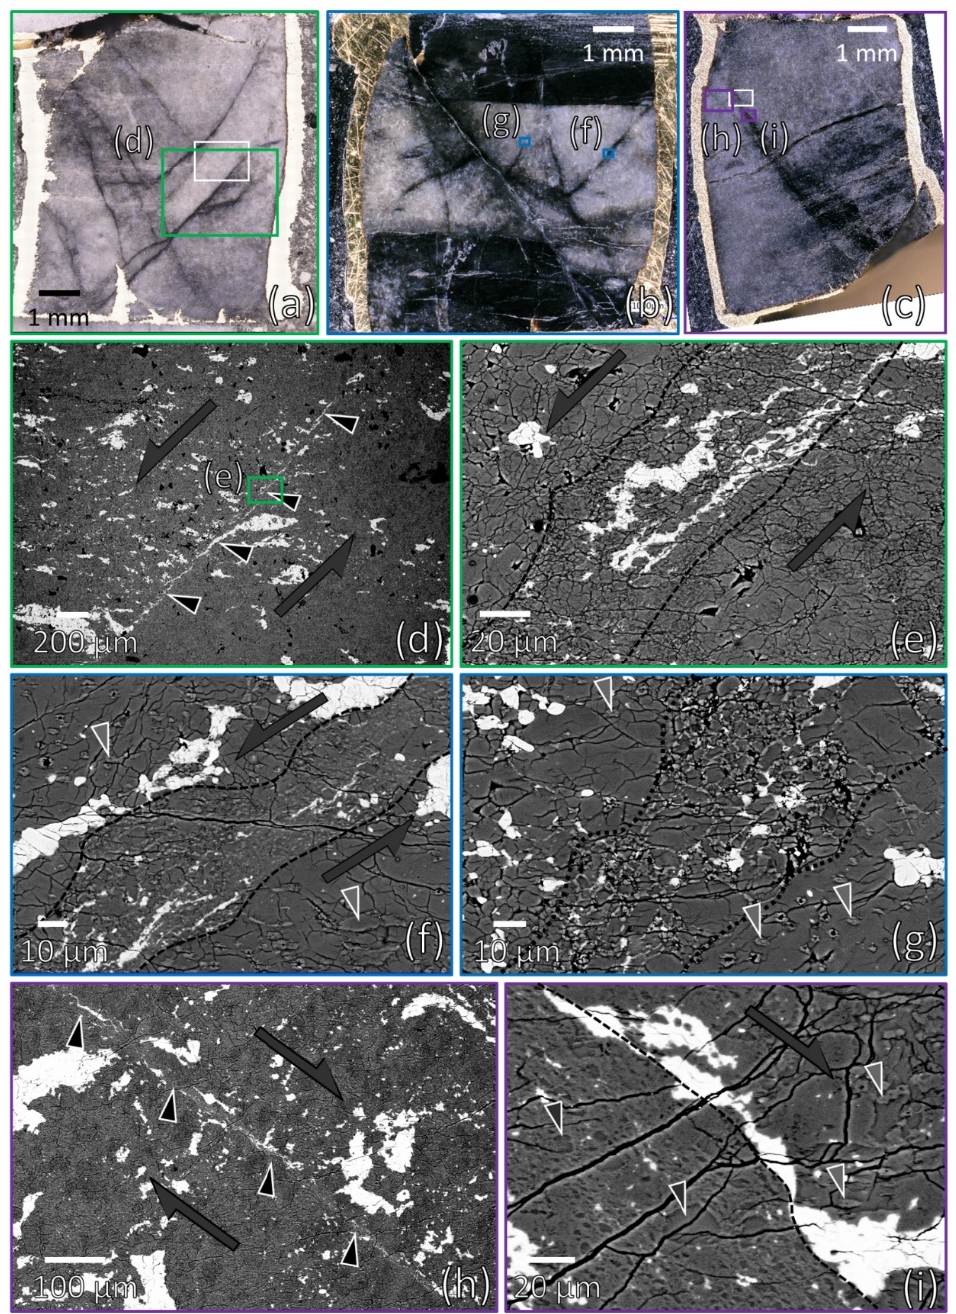
Figure 9. Images of samples deformed at 703 °C. ( a – c ) optical microscope images of samples G16, G22 and G23, respectively. White rectangles in ( a , c ) are the locations of the EBSD maps presented in Figure 11. ( d – i ) SEM images in BSE mode of the same samples according to the rectangles labelled in ( a – c ). Half-headed arrows indicate shearing kinematics. ( d ) Shearing of Ge-pyroxene grains (brighter color) in the center of the image reveals that the narrow Ge-spinel-rich regions seen in ( a ) correspond to faults (black arrowheads). ( e ) Shows a magnified view according to the rectangle in ( d ). The fault gouge is ~40 µm wide (contoured by the dashed lines) and contains a larger proportion of Ge-spinel than the adjacent undeformed areas. ( f ) High magnification view of a fault in sample G22 (dashed lines). Inside the fault, Ge-spinel is more abundant and presents a smaller grain size. Outside the fault, Ge-spinel is found evenly distributed in the form of small horizontal lenses (arrowheads). ( g ) High magnification view of the tip of a propagating shear band (incipient fault) in the same sample. Inside the fault, delimited by the dashed lines, Ge-spinel grows mostly at Ge-olivine grain boundaries, insensitive to principal stress and in contrast with the lenses it forms in the bulk of the sample (arrowheads). ( h ) The main fault of sample G23 is visible thanks to shearing